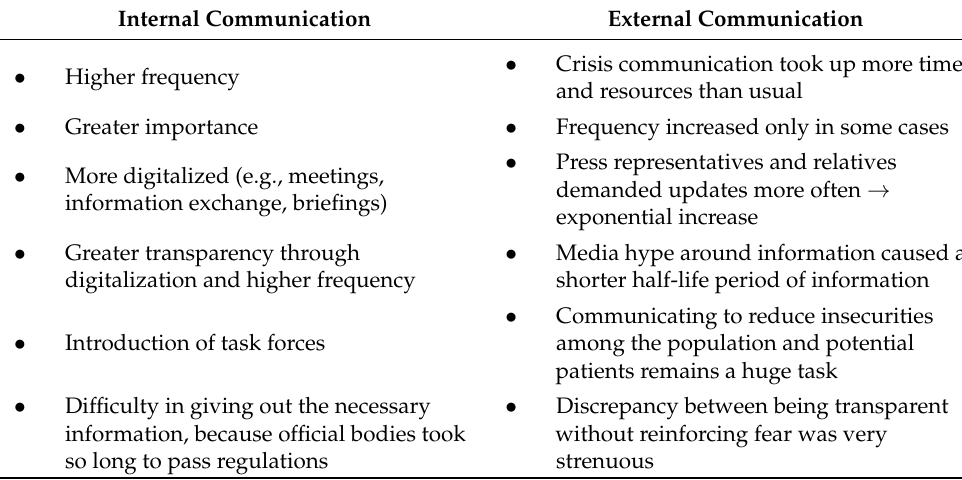
Table 4. Communication changes 1 —internal and